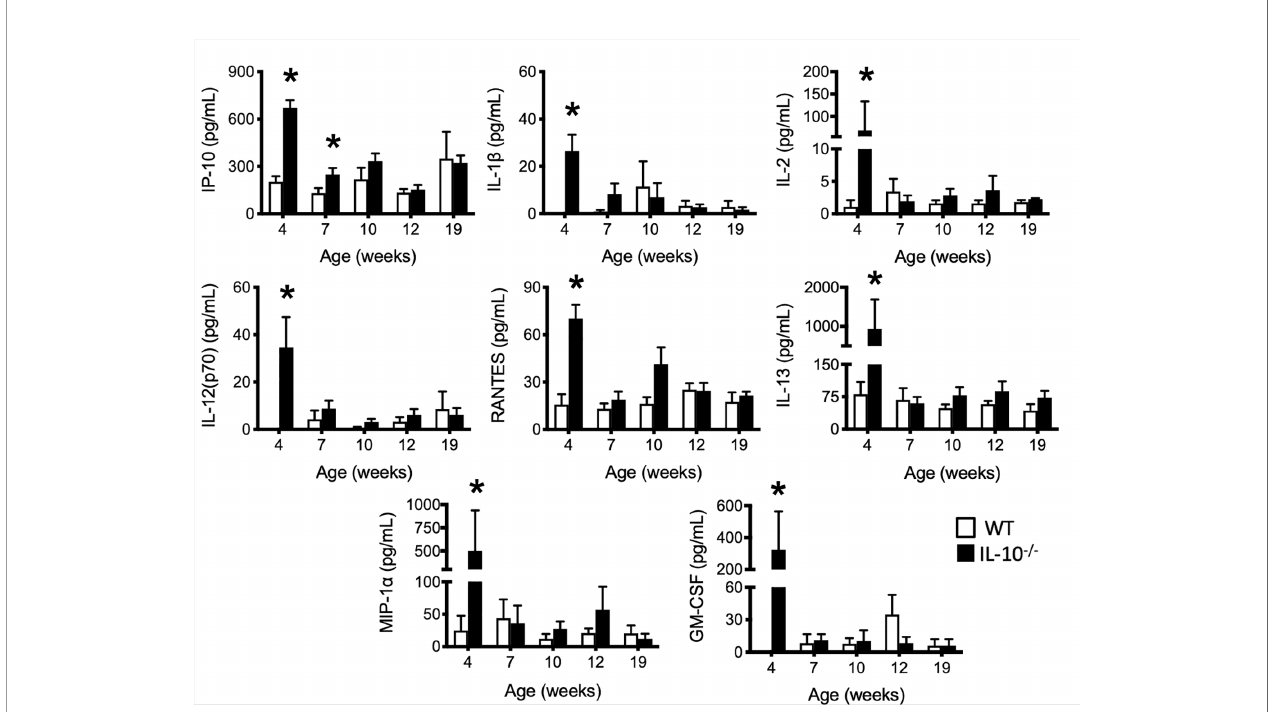
FIGURE 5 | Levels of selected serum cytokines and chemokines elevated at early time points in the serum of IL-10 -/- mice. Immune factors in serum samples collected between four and 19 weeks of age that were assayed included: IP-10, IL-1 b , IL-2, IL-12(p70), RANTES, IL-13, MIP-1 a and GM-CSF. Serum samples were collected from WT (white bars) and IL-10 -/- (black bars) mice. Data are presented as mean ± SEM. *= p ≤ 0.05 comparing samples between WT and IL-10 -/- mice at each time point. The number of mice used for each strain at each time point varied as follows: at 4 weeks of age, n = 5; at 7 weeks of age, n = 10; at 10 weeks of age, n = 9; at 12 weeks of age, n = 13; at 19 weeks of age, n =